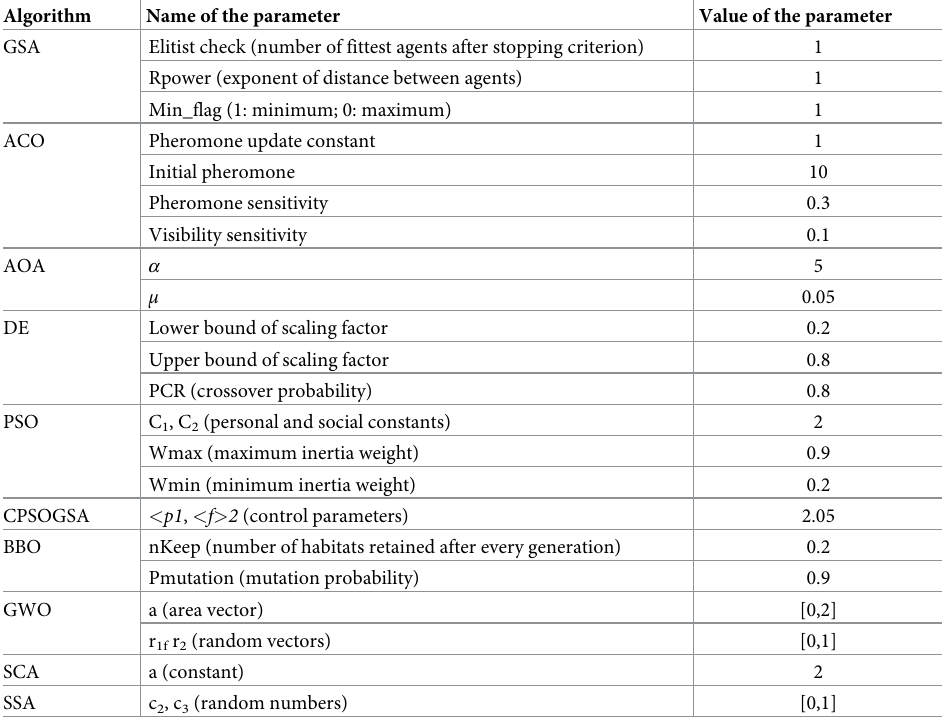
Table 1. Controlling parameters for algorithms